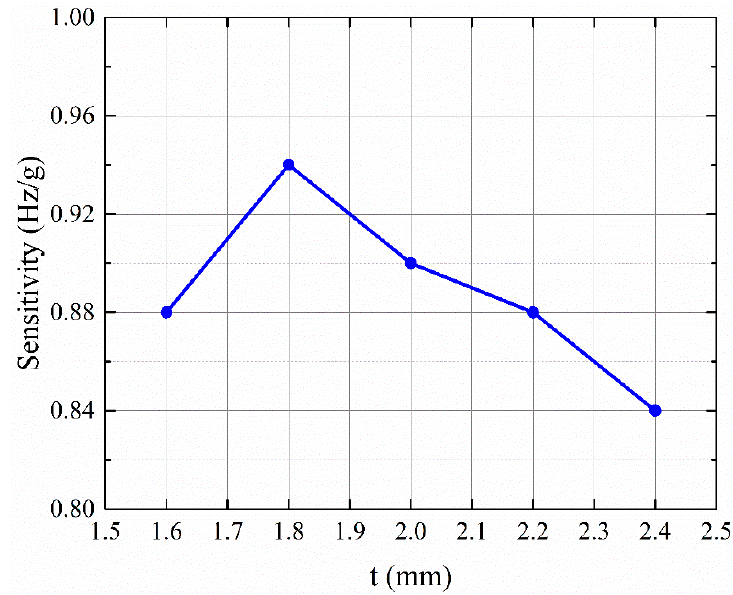
Figure 8. Relation between the thickness of the lower support beam and frequency shift of the DETF.